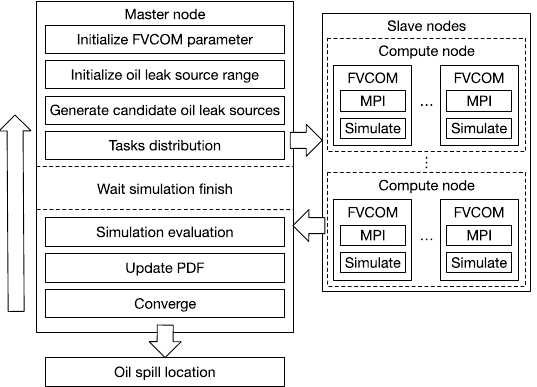
Figure 4. Illustration of the COSSD method parallel